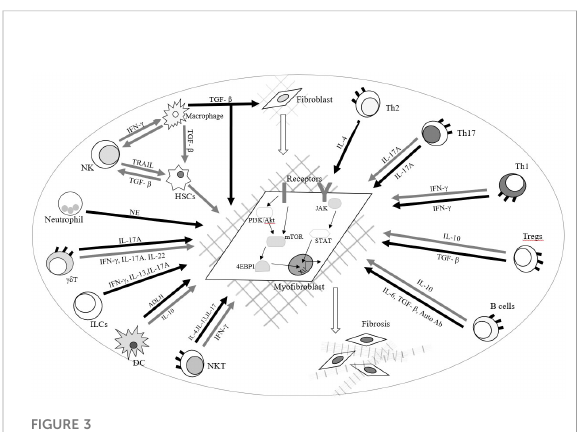
FIGURE 3 Roles of immune cells and fi broblasts in radiation-induced lung fi brosis and